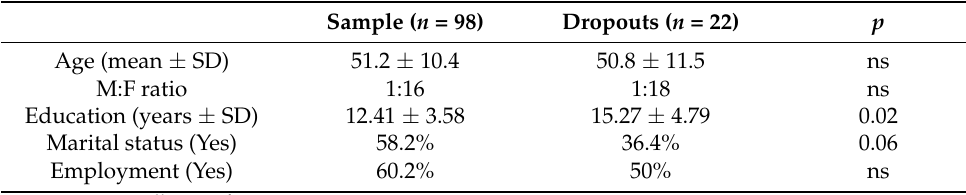
Table 1. Demographic characteristics of the whole population ( n = 120).